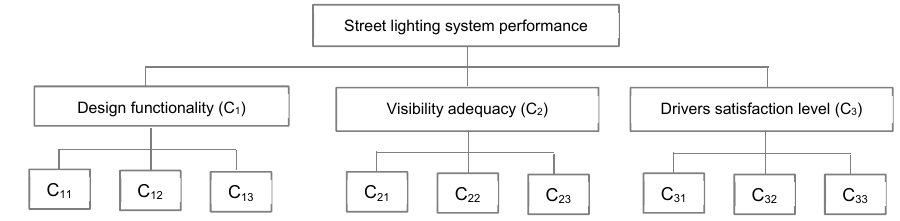
Figure 3. Hierarchical performance assessment approach for the urban street-lighting system. Details of sub-criteria at level 1 can be seen in Table 1.